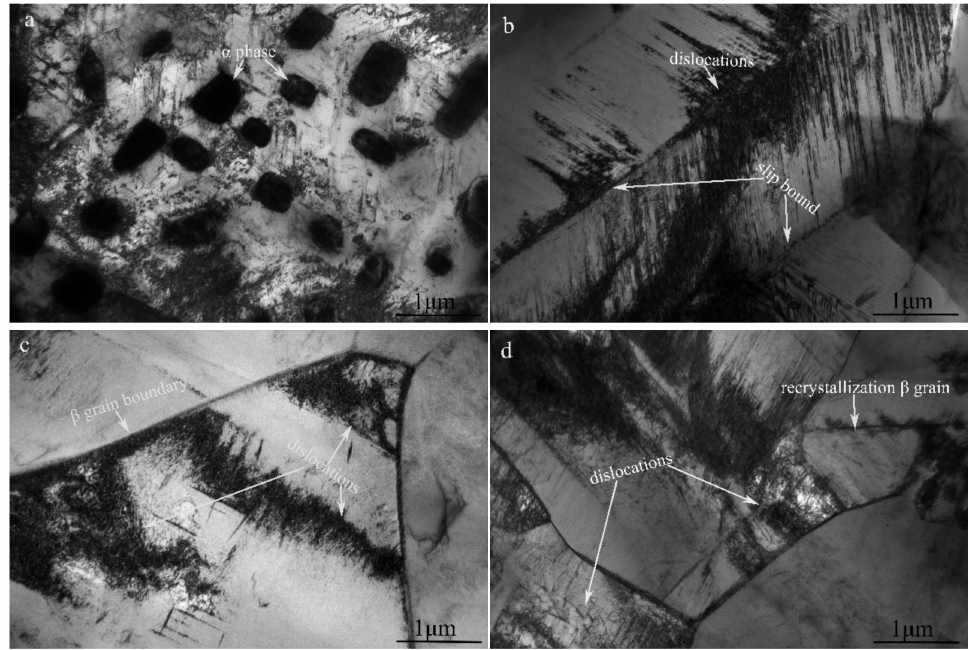
Figure 4. TEM of Ti-6Mo-5V-3Al-2Fe alloy under different deformation conditions: 750 ◦ C 0.0005 s − 1 ( a ), 800 ◦ C 0.0005 s − 1 ( b ), 850 ◦ C 0.0005 s − 1 ( c ), and 850 ◦ C 0.5 s − 1 ( d